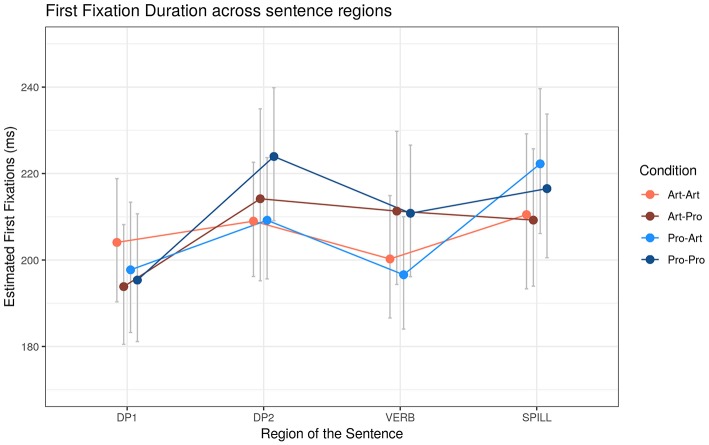
Estimated First Fixation (FF) reading times (ms) across sentence regions. Error bars represent 95% confidence intervals around the models' estimates.